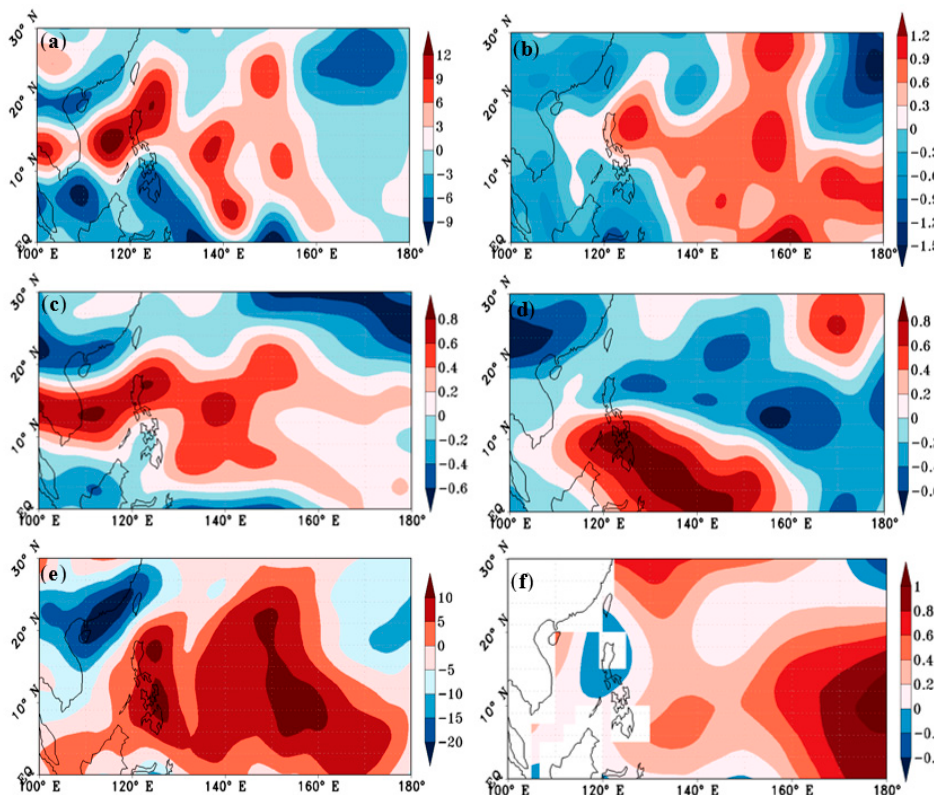
Figure 3. Differences in environmental factors in November 2019 compared to the climatological mean: ( a ) 850 hPa absolute vorticity (unit: 10 − 6 s − 1 ); ( b ) 500 hPa vertical velocity (unit: − 10 − 1 Pa s − 1 ); ( c ) meridional gradient of zonal wind at 500 hPa (unit: s − 1 ); ( d ) vertical wind shear (unit: m s − 1 ); ( e ) 600 hPa relative humidity (%); ( f ) sea surface temperature (unit: °C).